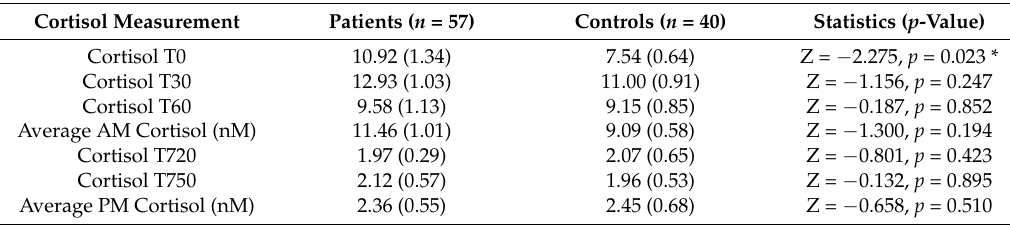
Table 2. Raw cortisol data for MDD patients and healthy controls.